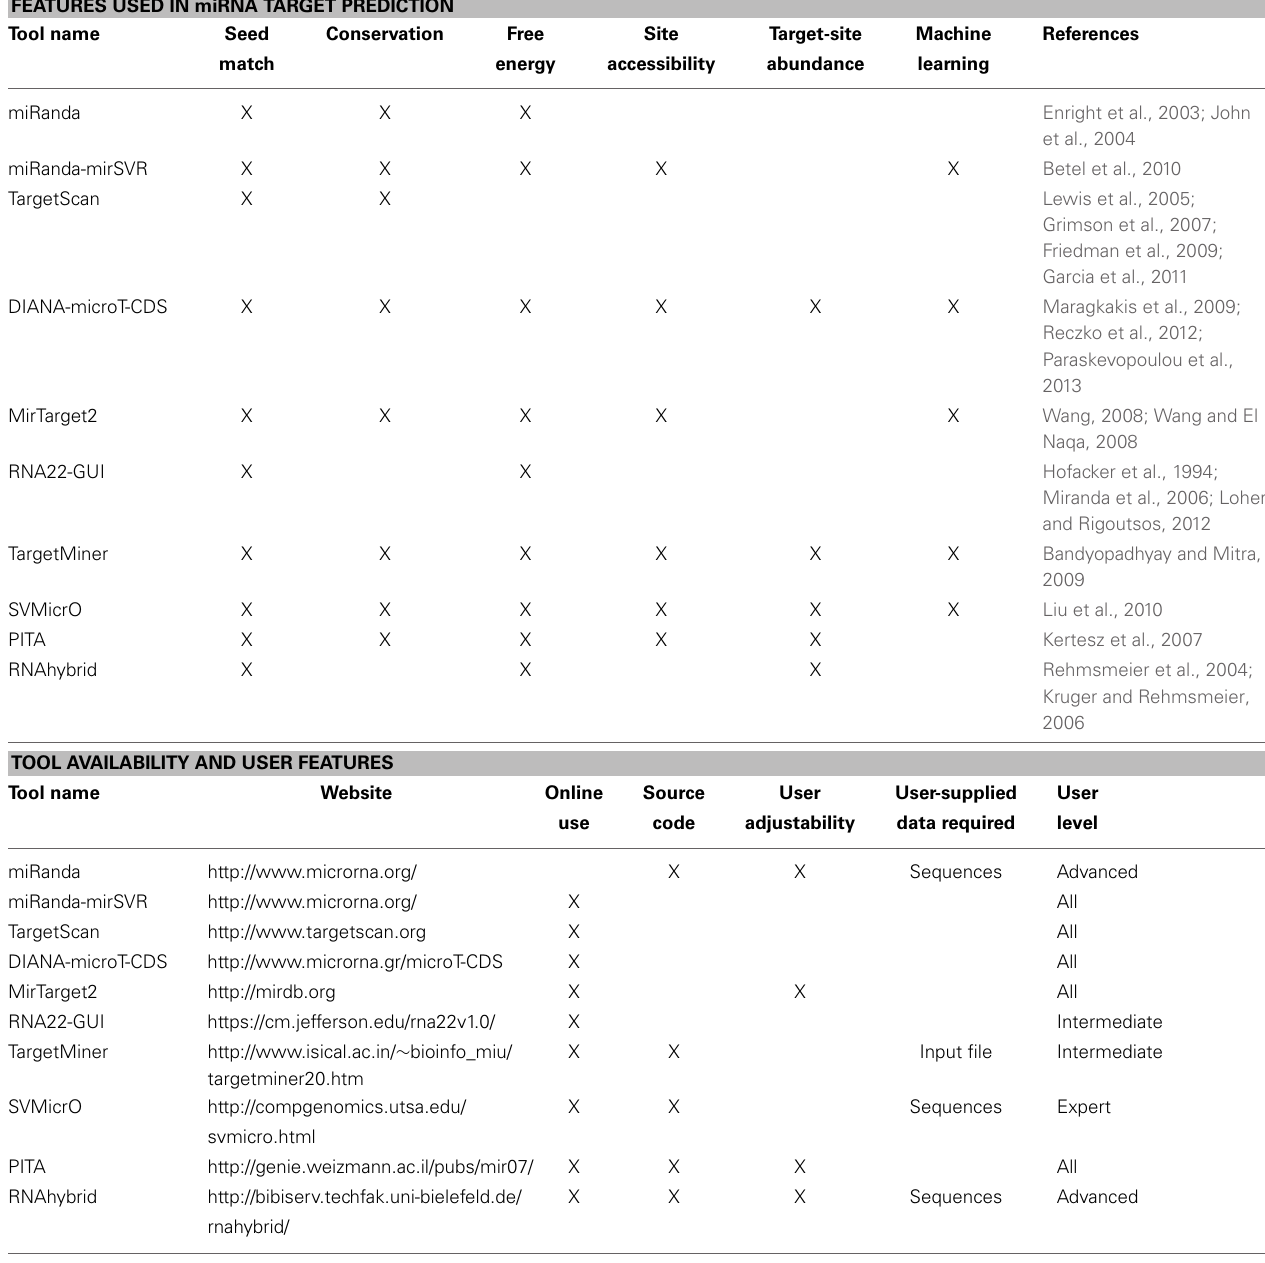
Table 11 | Summary table of miRNA target prediction